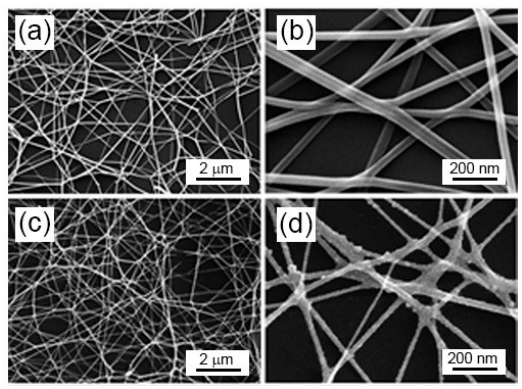
Figure 1. SEM images of electrospun WO 3 nanofibers. Panels ( a ) and ( b ) are respectively low and high magnification of as deposited NFs. Panels ( c ) and ( d ) represent the NFs after 1h annealing at 450 °C.